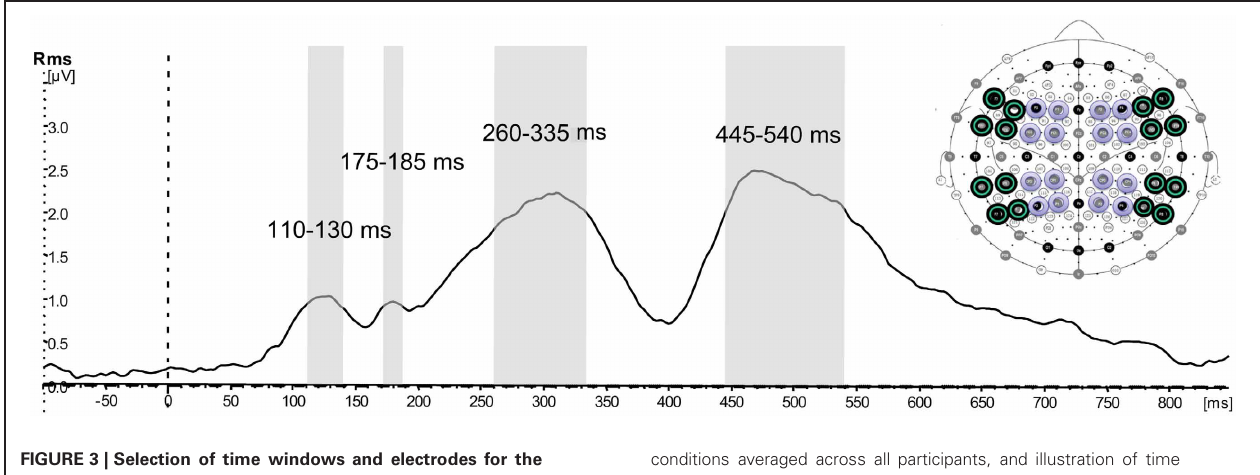
FIGURE 3 | Selection of time windows and electrodes for the topographical analysis. Global field power (GFP) calculated on the selection of 32 electrodes showing activation collapsed over all four